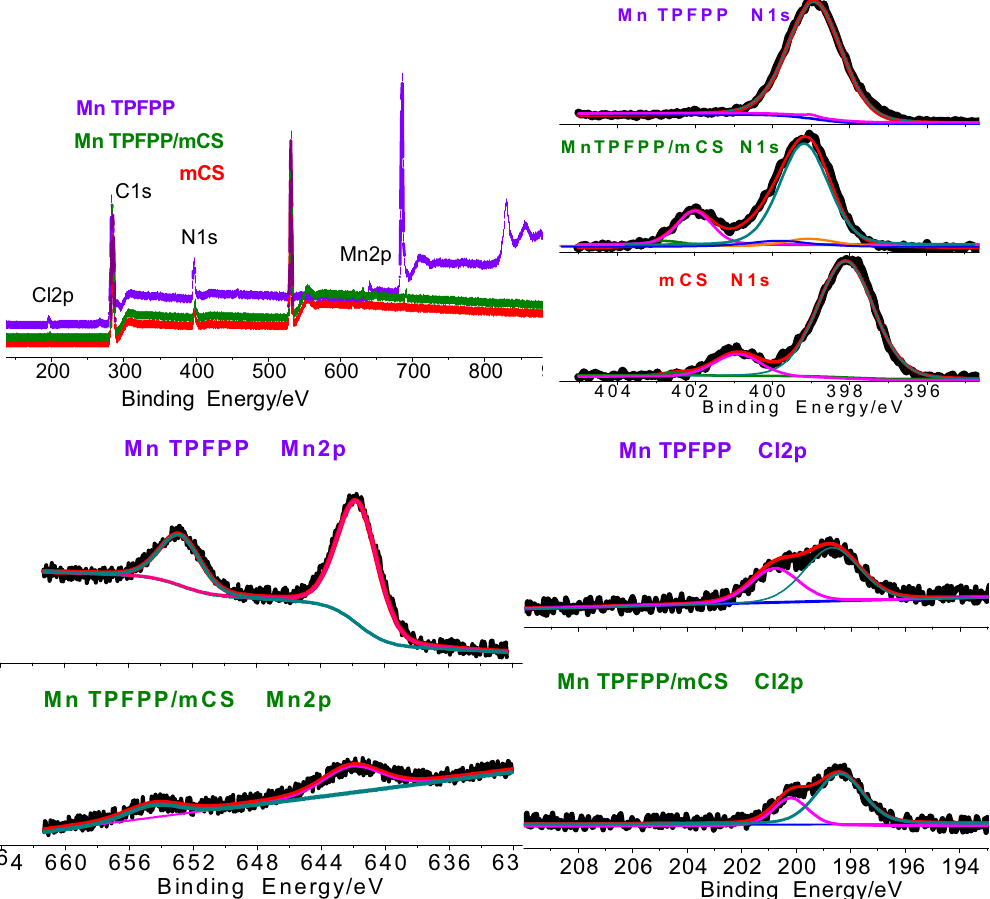
Figure 4. XPS spectra of Mn 2p, N 1 s and Cl 2p for mCS, Mn TPFPP, and Mn TPFPP/mCS.